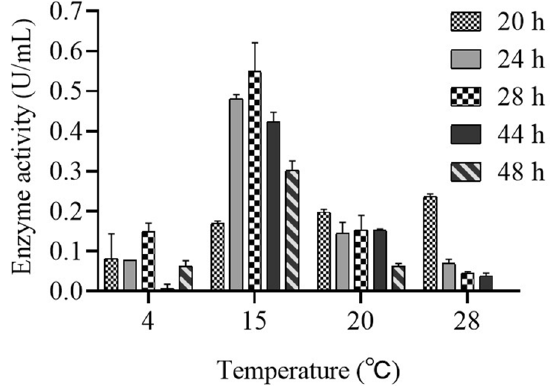
Fig. 1 Graphical representation of periplasmic L-ASNase activity when PCH199 was cultured at different temperatures (4, 15, 20, and 28 ℃ ). PCH199 was grown at different temperatures and periplasmic L-ASNase activity was measured at different time intervals from the culture of PCH199 corresponding to each